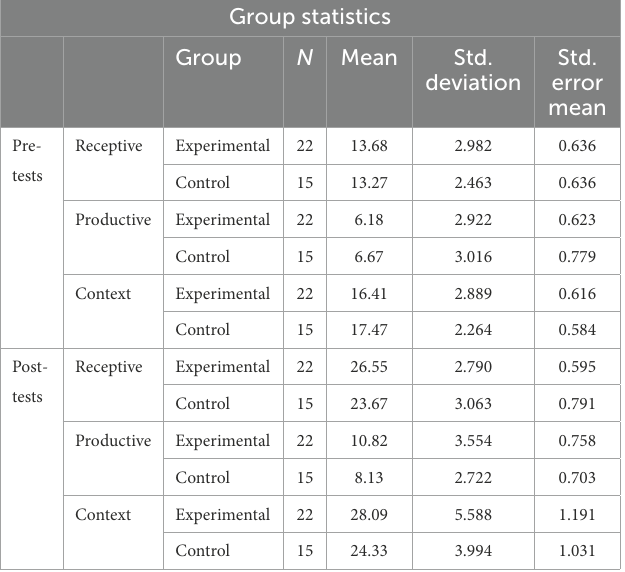
TABLE 1 Descriptive statistics for the scores obtained on pre- and post-